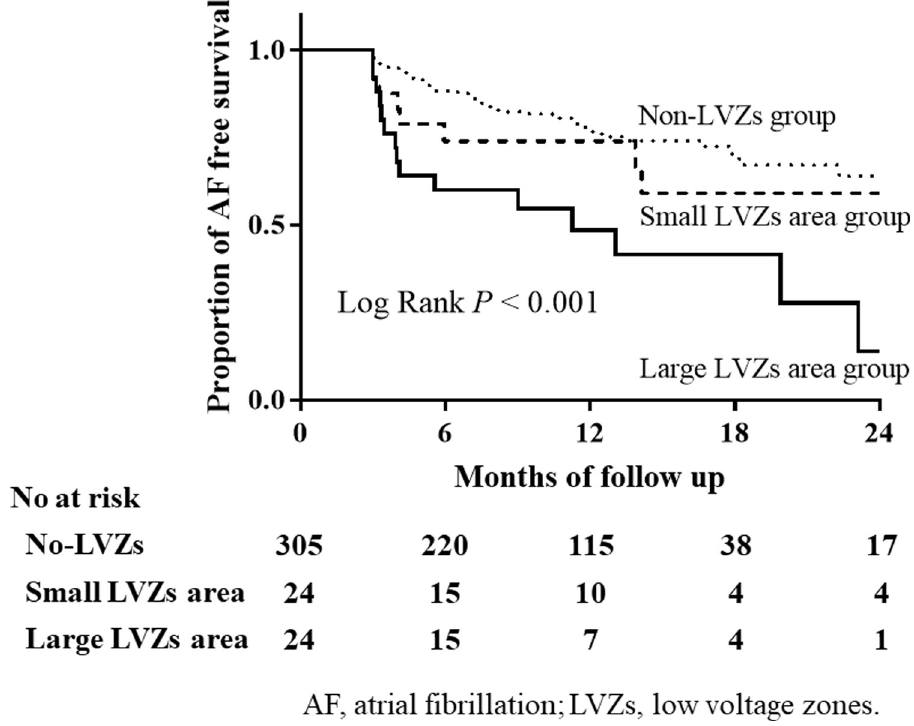
Fig 2. Kaplan-Meier curve of freedom from AF